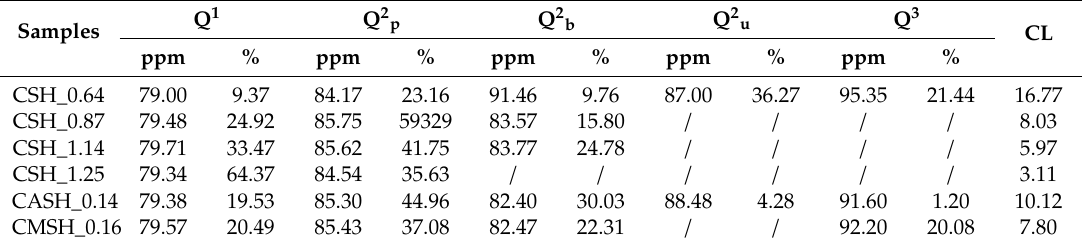
Table 2. Peak shifts, relative fraction of Q n , and mean chain length of C-(M)-(A)-S-H samples.